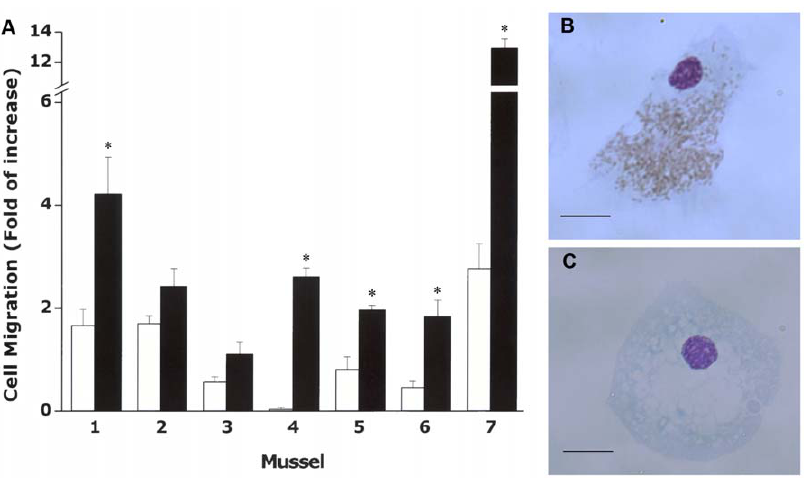
Figure 8. Chemotactic activity of Myt C. Chemotaxis of fresh hemocytes in response to lysates from CHSE transfected cells with pMCV1.4, pMCV1.4-eGFP and pMCV 1.4-Myt Ccon-eGFP vector and CHSE non-transfected cells. Hemocytes from individual mussels were seeded in the upper chamber and lysates from CHSE cells in the lower chamber. A. The number of migrating cells from representative individual mussels to the lower chambers is expressed as the mean 6 SD of the cellular counting of five different microscopic fields, relative to hemocytes migrating to lower chambers containing FSW. Asterisks denote statistically significant differences when comparing with CHSE non-transfected cells (p , 0.01). B. Aspect of representative hemocytes after migrating to the lower chamber containing pMCV 1.4-Myt Ccon-eGFP. C. Aspect of representative hemocytes after migrating to the lower chamber containing control treatments. Scale Bar: 10 m m.